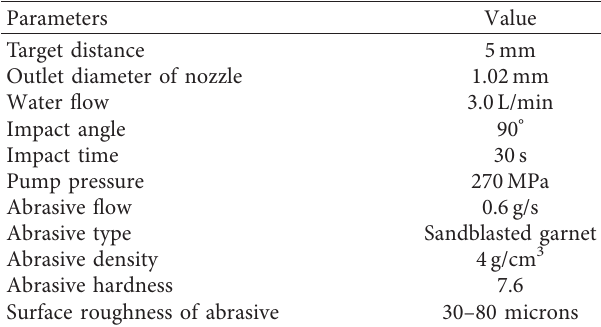
Table 1: Impact parameters applied in the